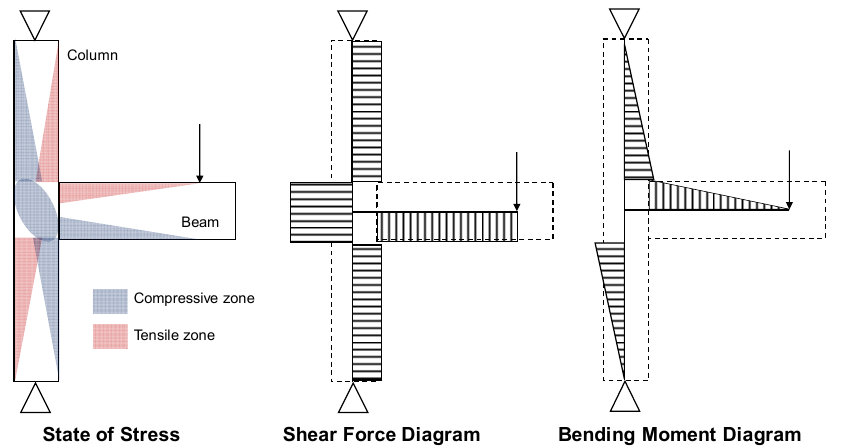
Figure 5. Load transfer mechanism in 2D beam–column joint sub-assembly.